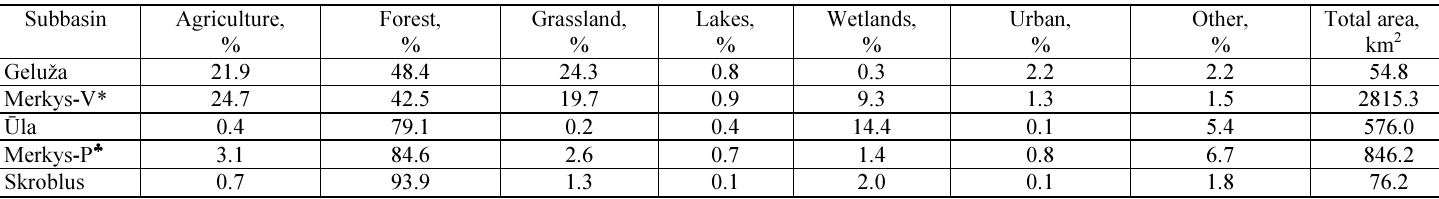
Fig. 1. Location map and water quality sampling sites in the Merkys River Basin Table 1. Land use and drainage area of subbasins above water sampling